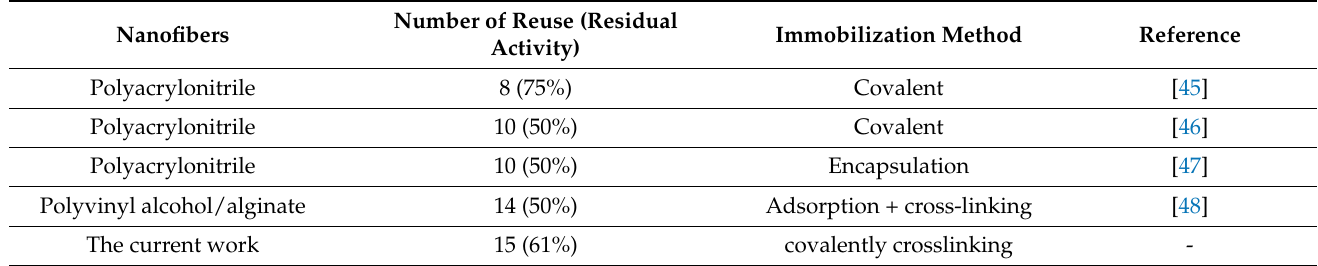
Table 2. Comparison of the reusability of the lipase enzyme immobilized on different modi- fied nanofibers.